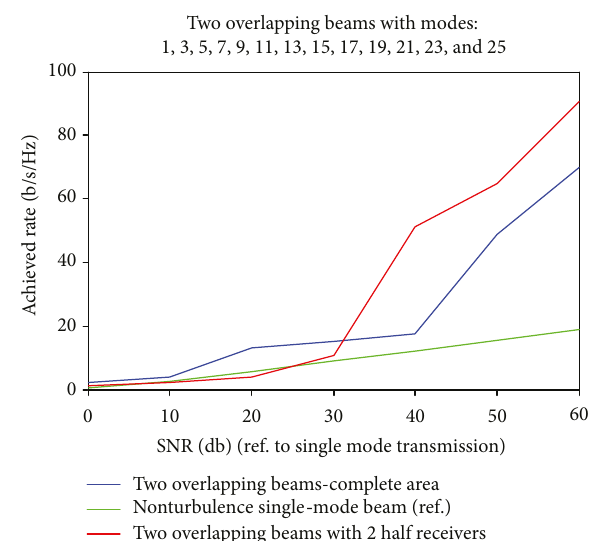
Figure 8: C 632.8